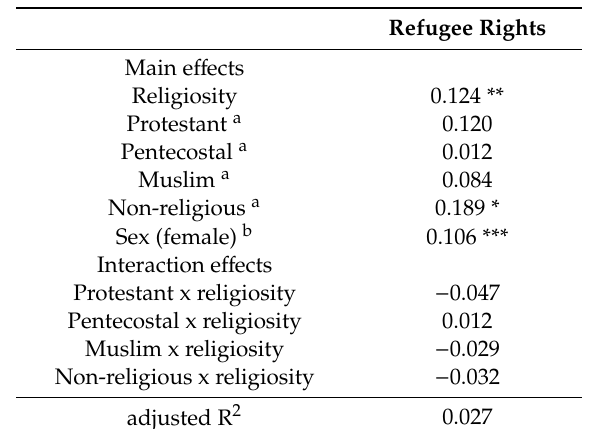
Table 2. The influence of religiosity, religious a ffi liation, sex, and the interaction between religiosity and denomination on attitudes towards refugee rights (ordinary least squares (OLS)